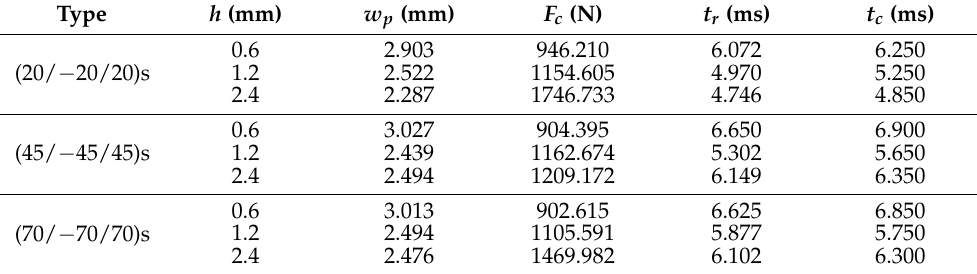
Table 10. Low-velocity impact response of the sandwich structure with various h s